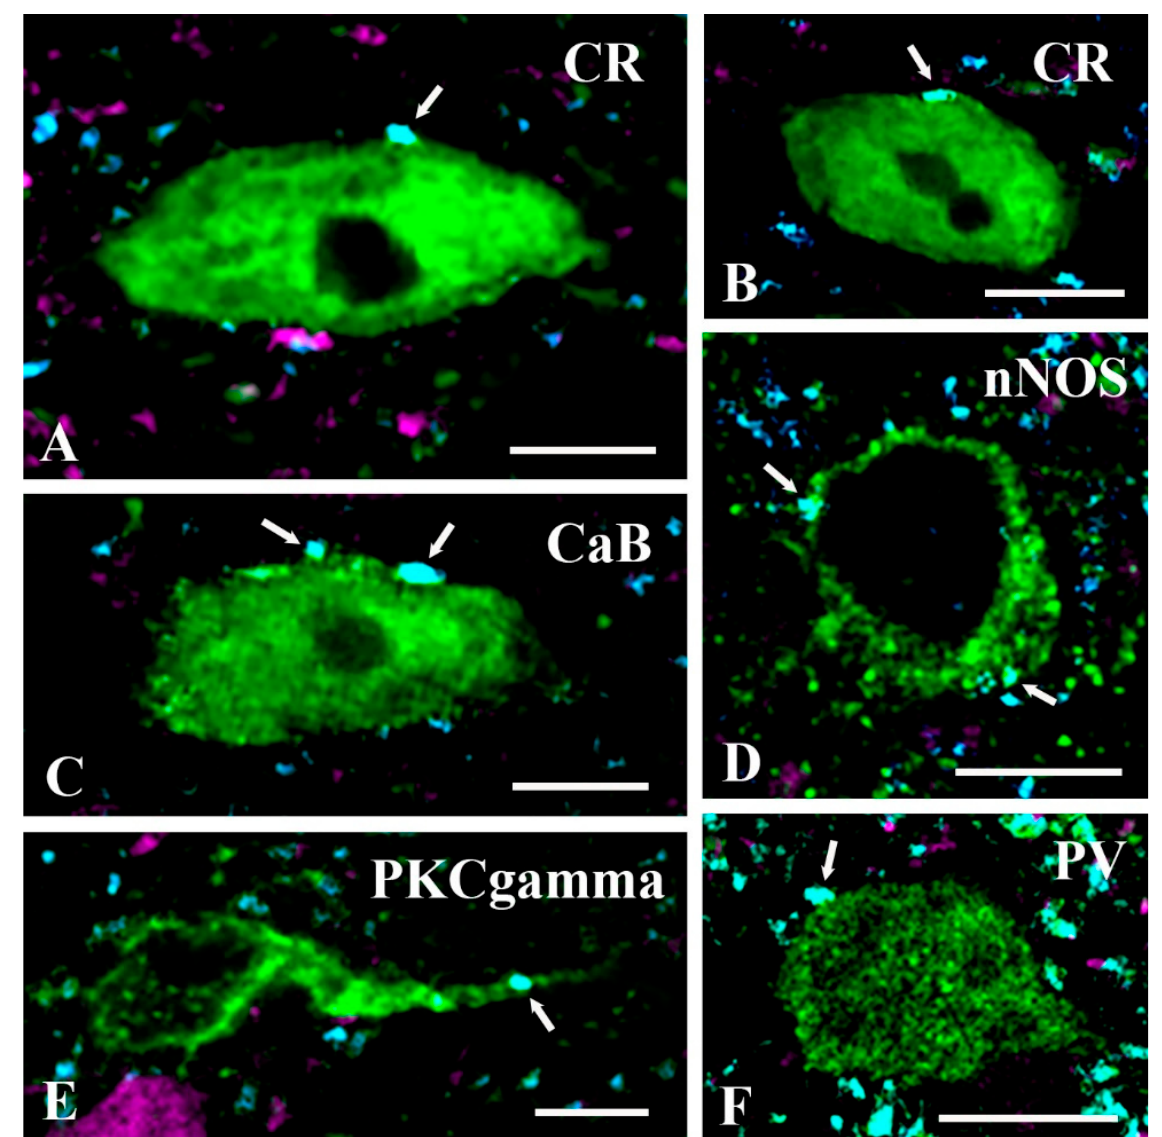
Figure 6. GlyT2 immunostained axon terminals make close appositions with excitatory spinal interneurons. Close appositions between glycine transporter 2 (GlyT2) immunoreactive axon terminals (cyan) and somata or proximal dendrites of calretinin (CR) ( A , B ), calbindin CaB) ( C ), neuronal nitric oxide synthase (nNOS) ( D ), protein kinase C gamma (PKCgamma) ( E ), and parvalbumin (PV) ( F ) immunoreactive (green) and PAX2Cre-tdTomato (magenta) negative excitatory interneurons. Arrows indicate GlyT2 immunostained axon terminals forming close appositions with the labeled neurons. Bars: 10 µm.